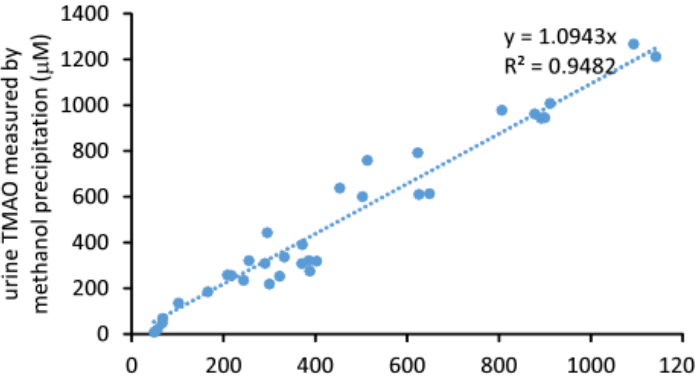
Figure 6. Correlation between the two different methods for the measurement of urine TMAO. Hexane/butanol extraction performed as described in Figure 5. For the methanol precipitation method, urine was diluted 20 times first, then mixed with 4 volumes of methanol containing 10 μM d9-TMAO as the internal standard following the method for the determination of the plasma TMAO